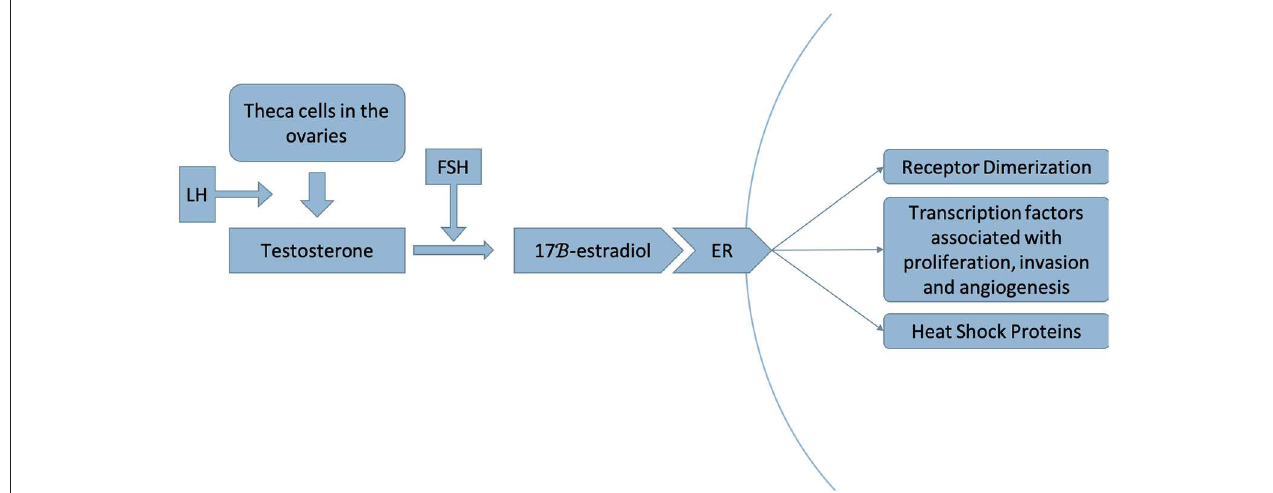
FIGURE 2 | Luteinizing hormone (LH) stimulates the production of testosterone by theca cells in the ovaries. Testosterone is then converted to 17 β -estradiol by the aromatase enzyme, a step that is stimulated by follicle-stimulating hormone (FSH) ( 17). This process occurs in adipose tissue as well as in muscle, liver, brain tissue and breast tumors (18). Estradiol acts as a ligand to the estrogen receptor (ER), dissociating the heat shock proteins from the receptor and inducing receptor dimerization, thereby activating a signaling pathway that recruits transcription factors associated with proliferation, invasion and angiogenesis of breast cancer ( 19).